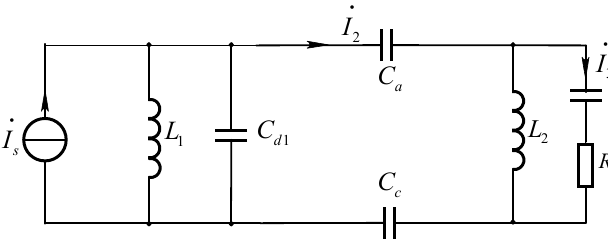
Figure 5. The simplified circuit diagram.